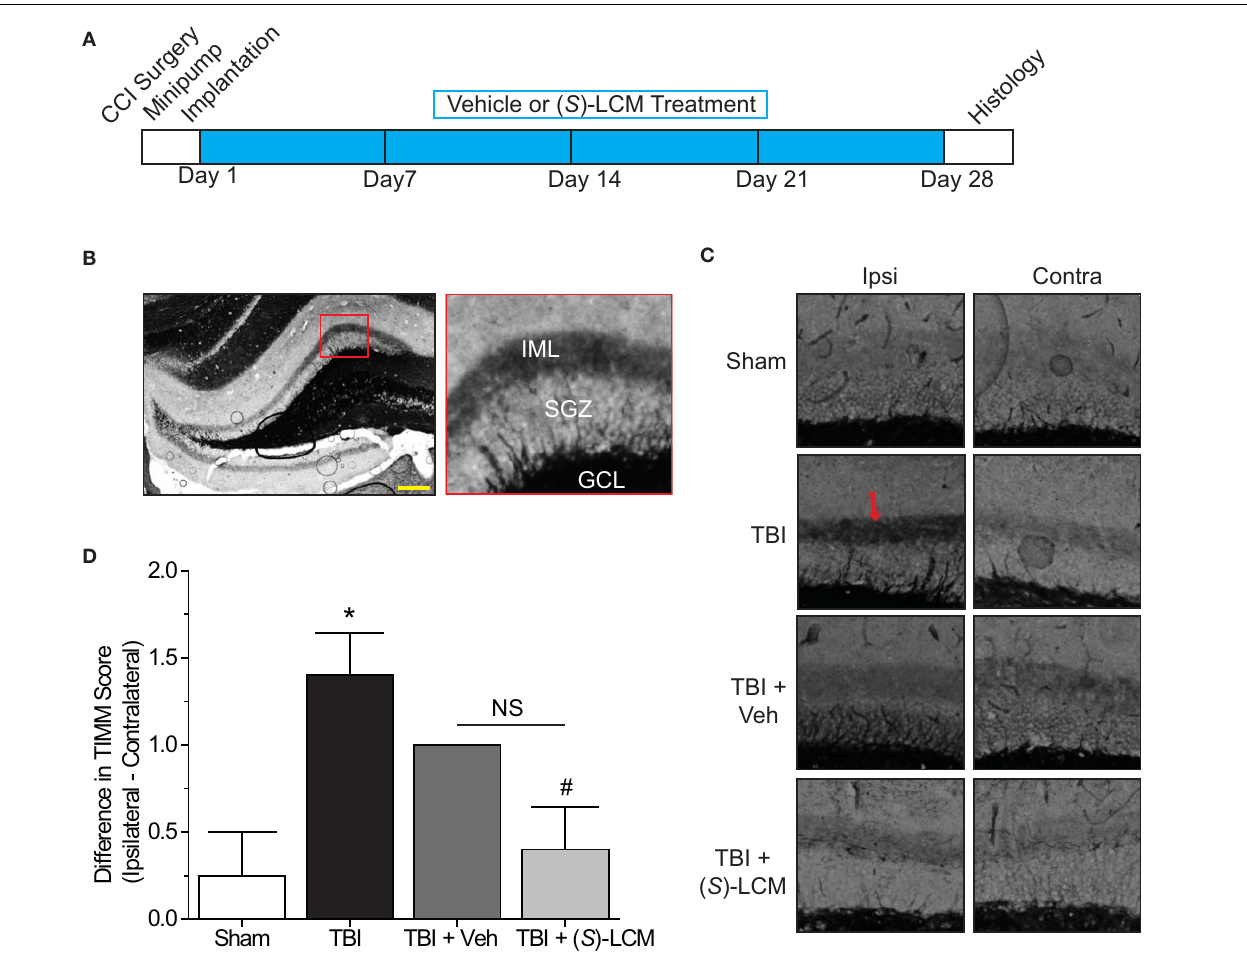
FIGURE 7 | Effects of targeting CRMP2 in vivo on mossy fiber sprouting. (A) Timeline of experimental design. Animals received either controlled cortical impact or sham (craniotomy) surgery. Immediately following surgery, animals were implanted with osmotic mini-pumps containing either vehicle or ( S )-LCM to be continuously infused at < 0.01% DMSO and ∼ 5mg/kg per day. Following 4 weeks of treatment, tissue samples were prepared for histology. (B) Representative low-magnification image of a TIMM-stained coronal section. Red box depicts region quantified for the extent of mossy fiber sprouting into the inner molecular layer. (C) Representative 10 × -magnification images of ipsilateral and